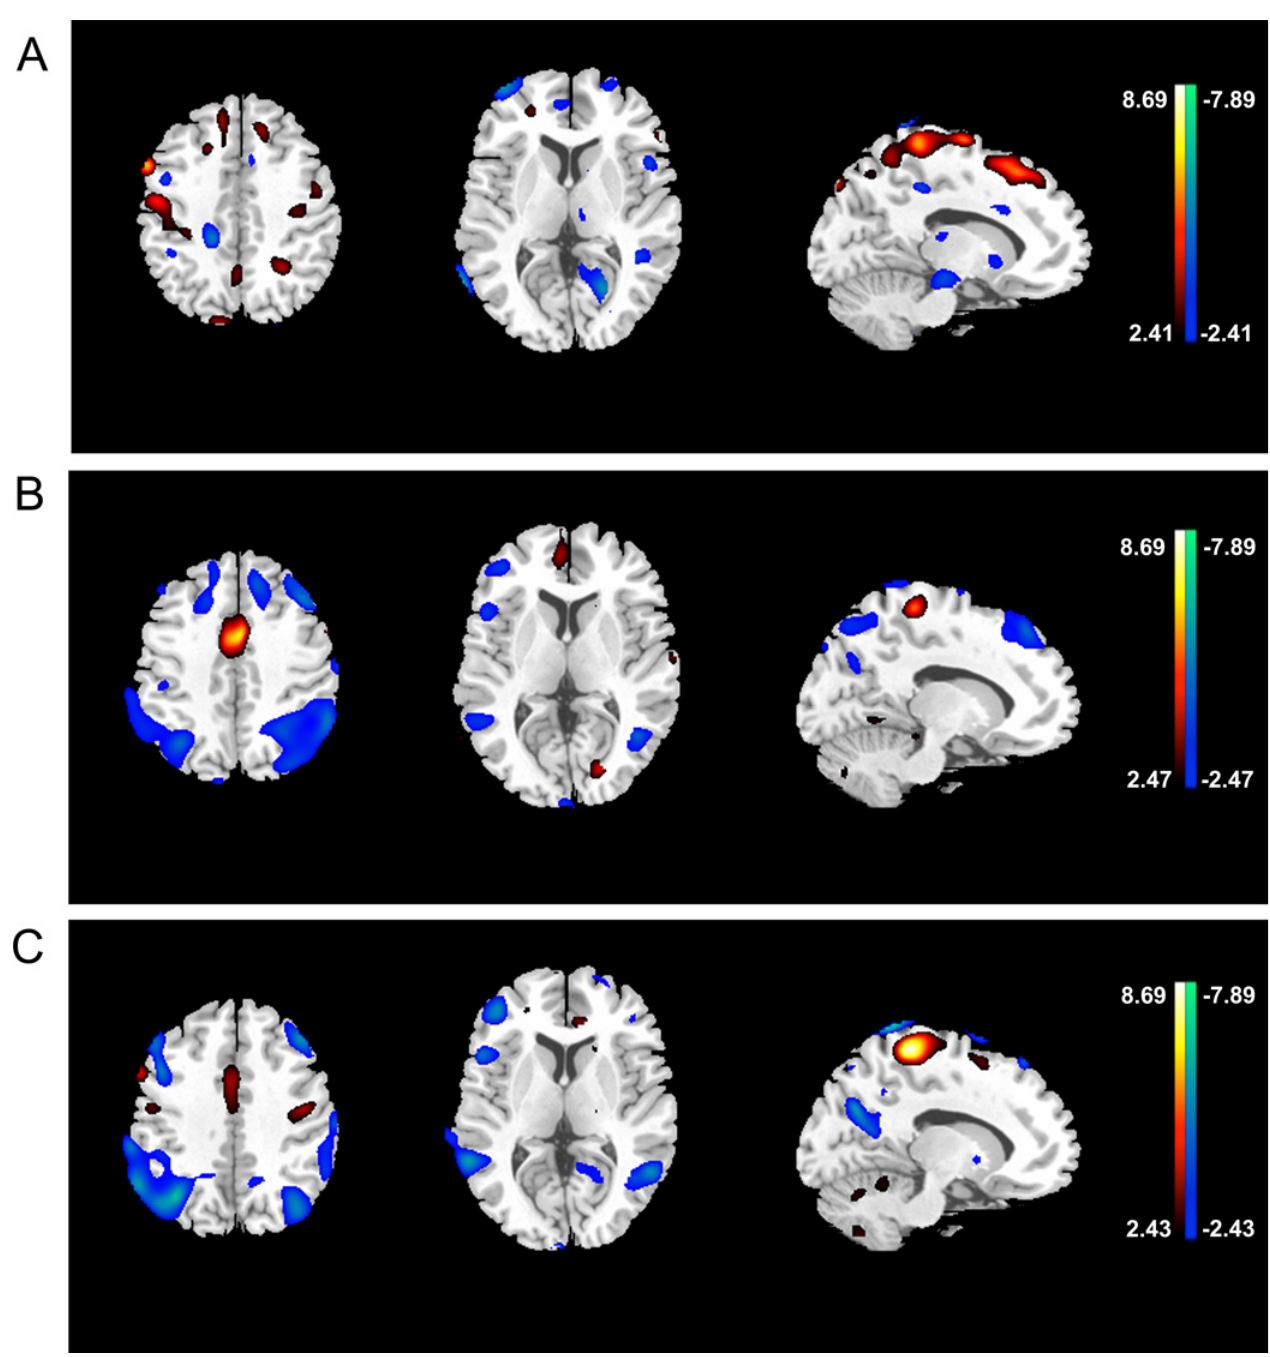
Fig 1. Group comparison of regional metabolic changes between PD groups utilizing voxel-based statistical parametric mapping analysis. Metabolic increases are displayed using a red – yellow scale and declines are displayed using a blue – purple scale. Both displays were superimposed on a single-subject MRI brain template and thresholded at p = 0.01 (uncorrected). (A) PD-MCI VS. PD-NC, (B) PDD VS. PD-MCI, (C) PDD VS.